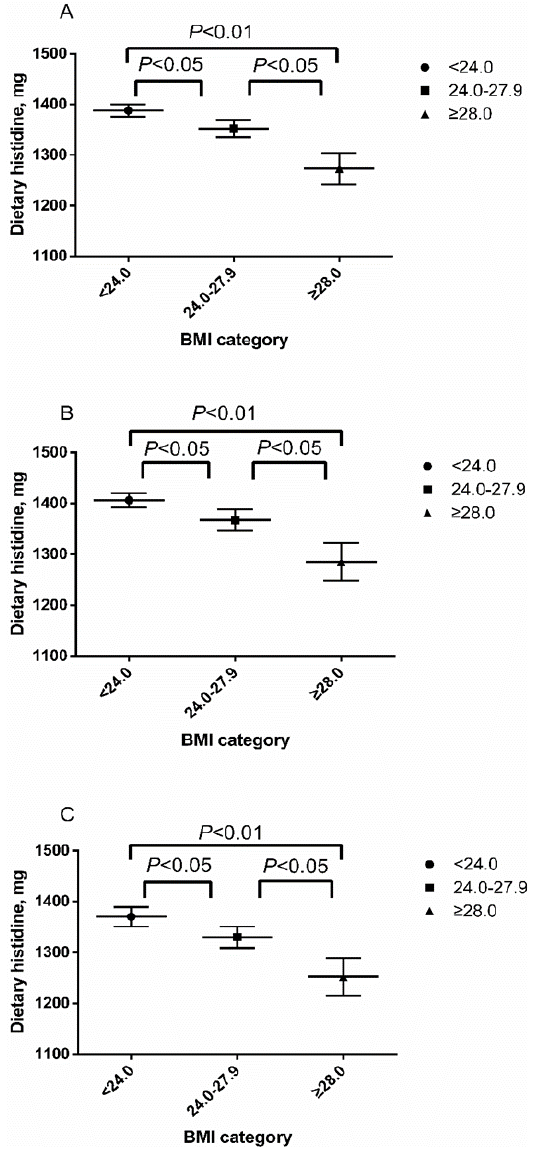
Figure 2. Dietary histidine of different body mass index (BMI) categories: ( A ) the overall population; ( B ) male participants; and ( C ) female participants. Confounding factors such as age, labor, exercise status, dietary carbohydrate, fat, protein, fiber and cholesterol intake and smoking habits were controlled.